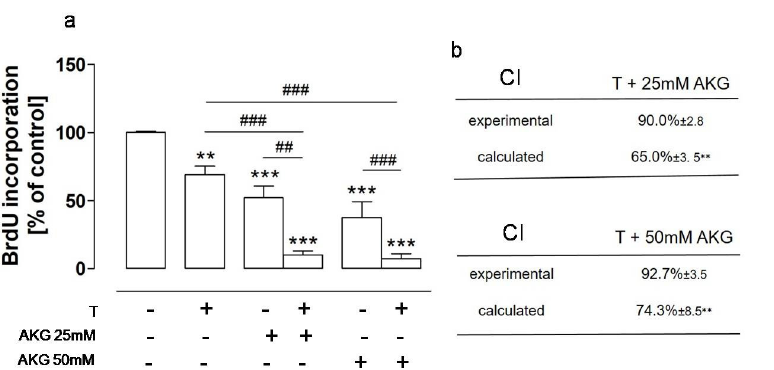
Figure 6. Enhanced antiproliferative activity of combined treatment of osteosarcoma cells with AKG and thiorphan. The HOS cells were treated with thiorphan (T, 500µM) and AKG (25mM or 50mM) for 72 h. The proliferation of the cells was examined by means of the BrdU assay (a), and the combination index (CI) was calculated with the method described by Peters et al. [37] (b). The re- sults were expressed as a percent of the BrdU incorporation level in the control cells. Statistically significant differences: ** p <0.01, *** p <0.001, in comparison with the control cells or in comparison with the experimental combination index; ## p <0.01, ### p <0.001 in comparison with T- or AKG-treated cells, respectively (one-way ANOVA followed by Tukey’s post-hoc